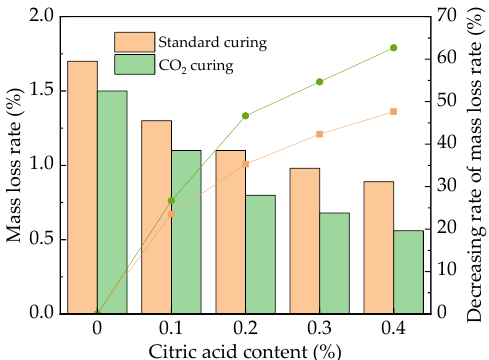
Figure 12. The mass loss rate of the MOS paste after 60 sulfate dry-wet